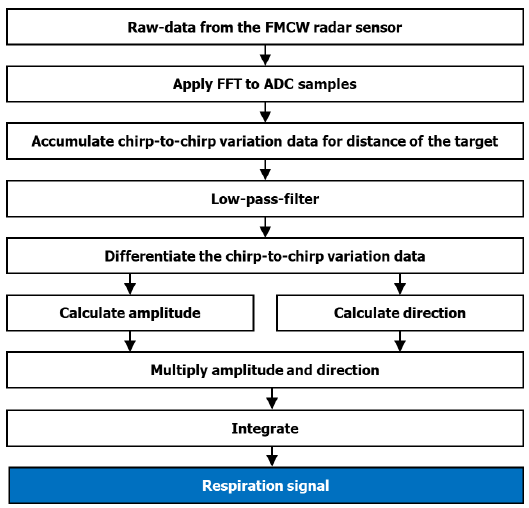
Figure 3. A flowchart describing the extraction of respiratory signals from radar signals.